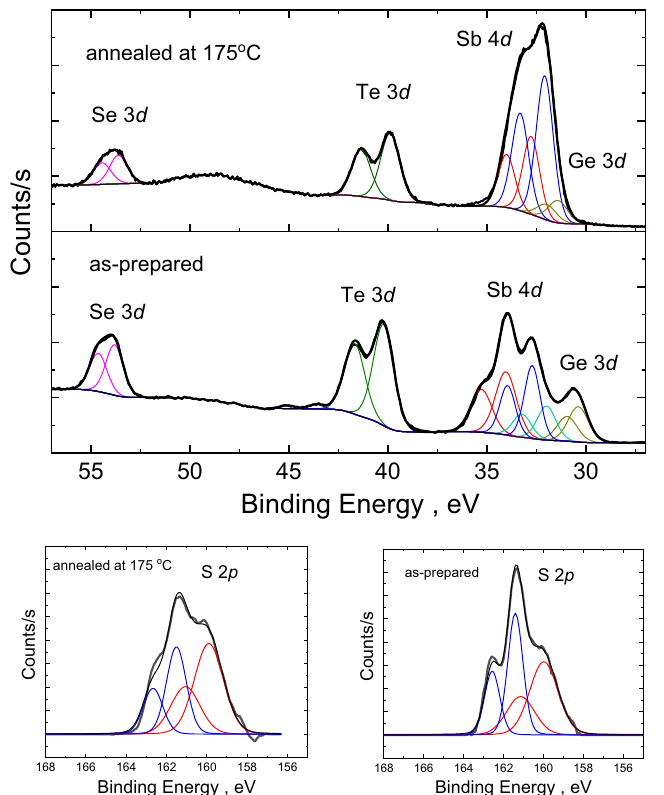
Figure 9. XPS results (bold line—experimental curve; thin lines—fitting components). Comparison of the XPS spectra, recorded for Ge 15 Sb 40 S 15 Se 15 Te 15 thin film in as-prepared amorphous and annealed at 175 °C states, shows significant difference for Sb, Ge and S core levels. This allows to further refine the mechanism proposed on the basis of Raman and XRD studies.